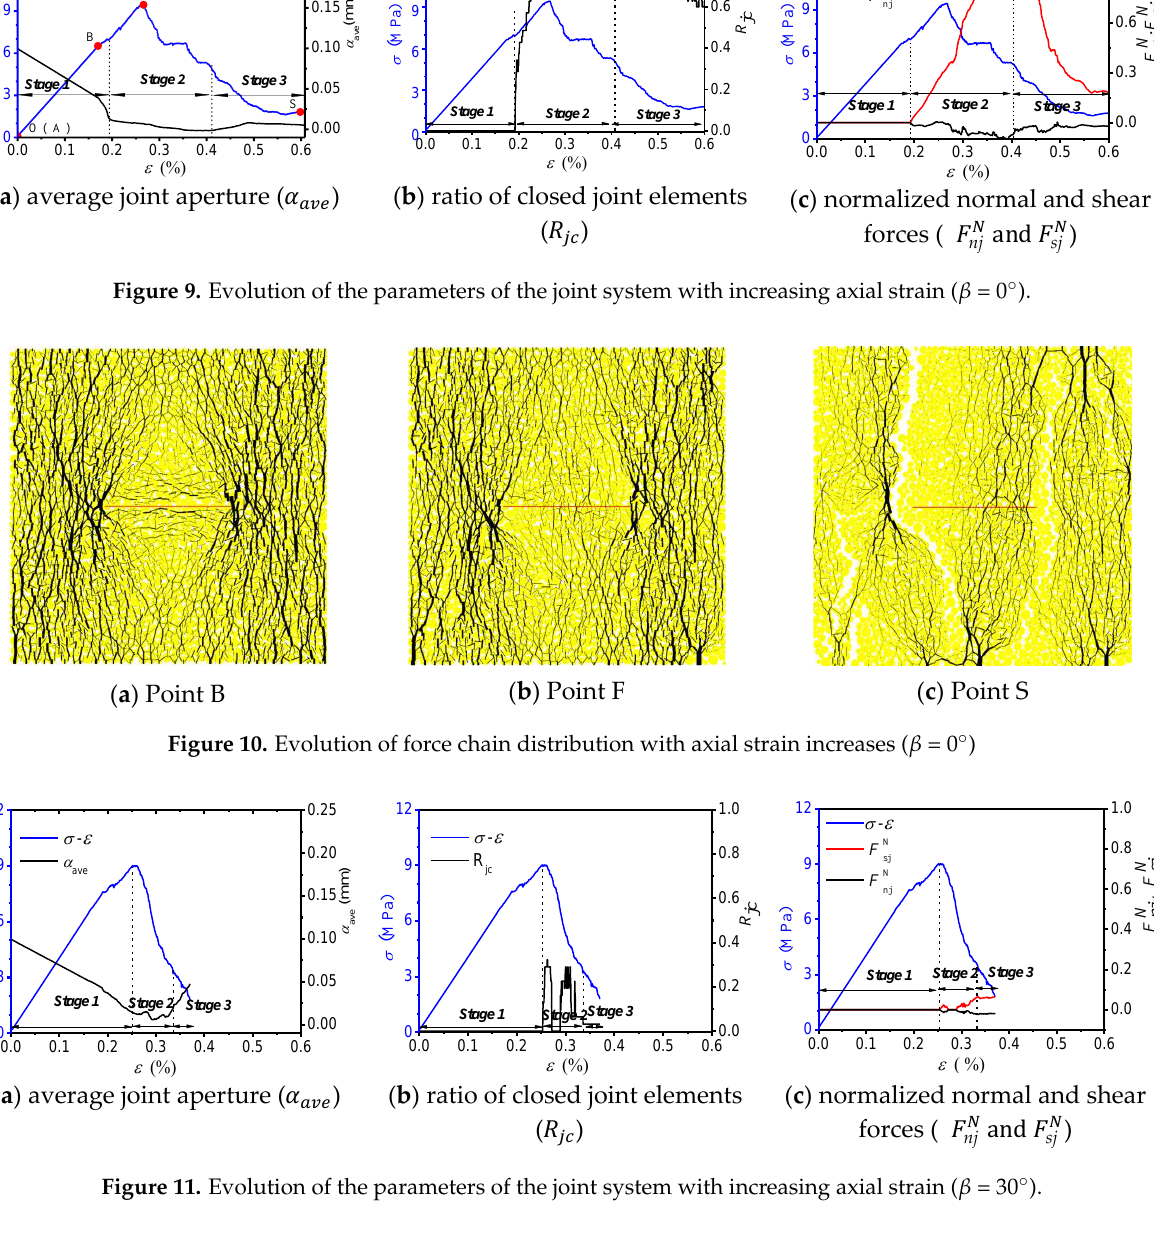
Figure 12. Evolution of force chain distribution with axial strain increases ( 𝛽 =30°). 0.0 0.1 0.2 0.3 0.4 0.5 0.6 0369 1215